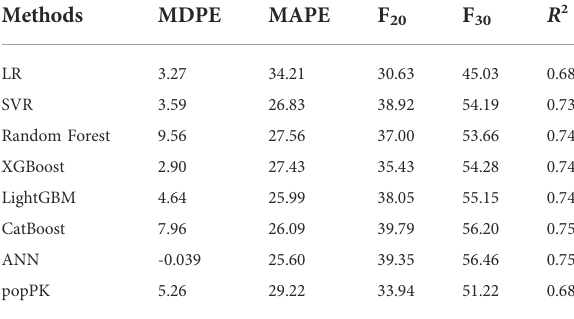
TABLE 2 Predictive performance of seven ML models and previously built popPK model in the evaluation dataset.